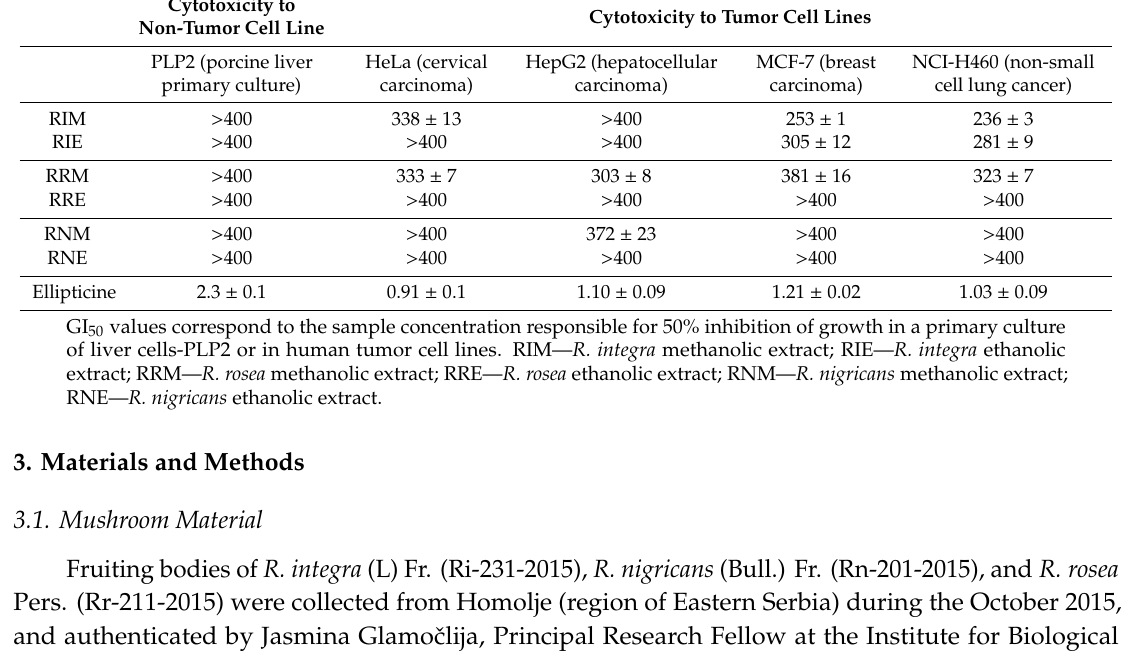
Table 6. Cytotoxicity and antitumor activity of the studied samples (GI 50 values µ g / mL, mean ± SD). Cytotoxicity to Non-Tumor Cell Line